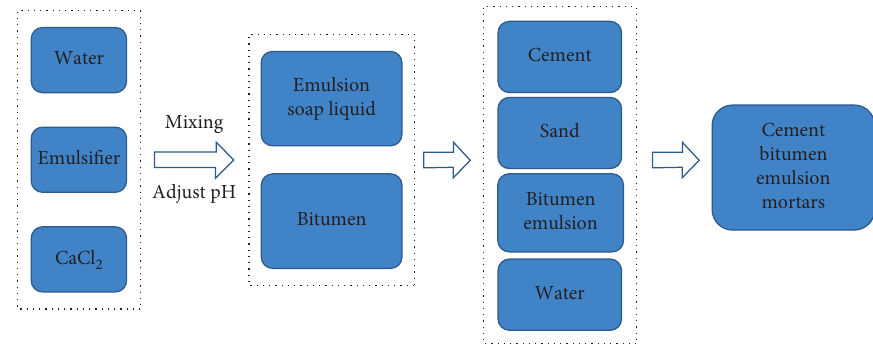
Figure 1: Flowchart of CBEM